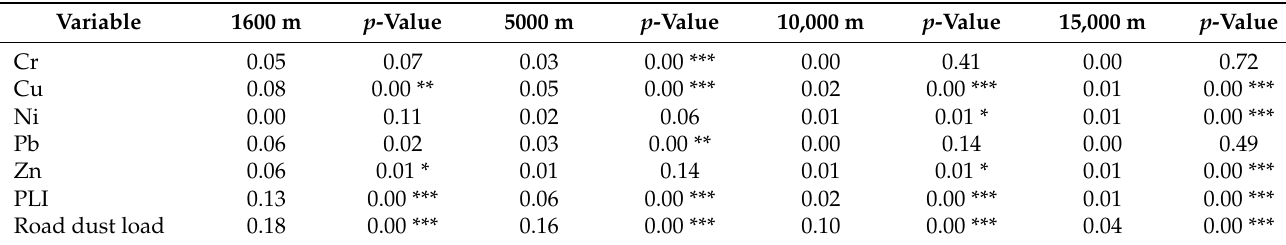
Table 3. The global Moran’s I and test of statistical significance at different vicinity distances (1600, 5000, 10,000, and 15,000 m).